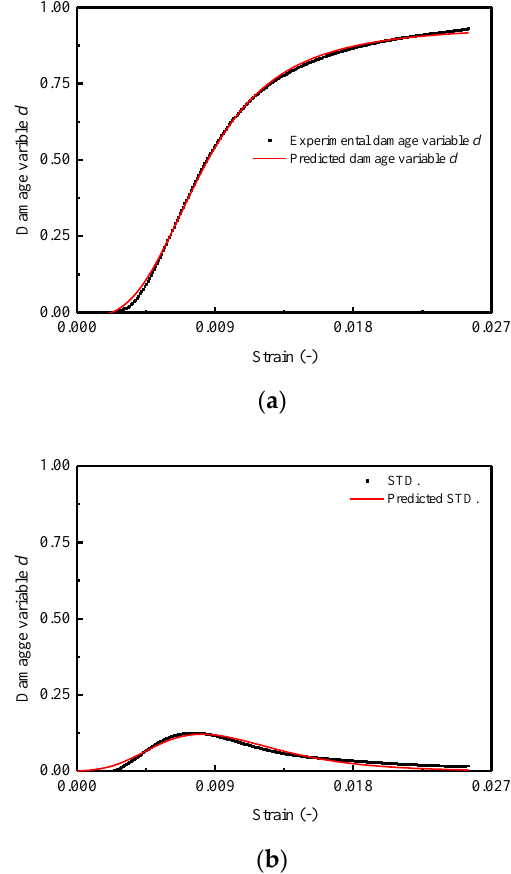
Figure 11. Comparison between experimental and theoretical curves for damage variable d : ( a ) Mean curve of d ; ( b ) STD. curve of d.